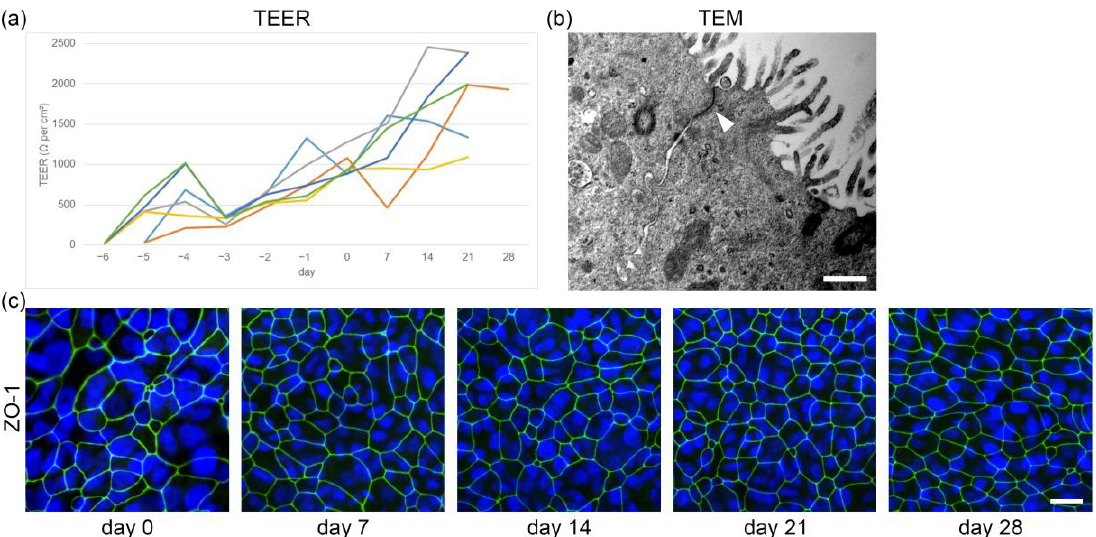
Figure 3. Assessment of tight junctions expressed in primary tracheal epithelial cells under air–liquid interface (ALI) conditions. ( a ) The formation of tight junctions during primary tracheal epithelial cell proliferation and differentiation was confirmed using transepithelial electrical resistance (TEER) measurements in ALI cultures derived from six individual dogs, ranging from day 6 to day 28 after initiation of ALI conditions. Each color of displayed lines represents values of an individual animal. ( b ) Tight junctions (arrowhead) along the epithelial cell borders were observed using transmission electron microscopy (TEM). Scale bar represents 500 nm. ( c ) ALI cultures were grown for the indicated number of days at ALI and fixed on the membranes. Immunofluorescence staining was performed with an anti-zonula occludens-1 (ZO-1) antibody labeling tight junctions in green and nuclear counterstain in blue. Representative images are shown of ALI cultures at days 0, 7, 14, 21 and 28. Scale bar represents 20 µ